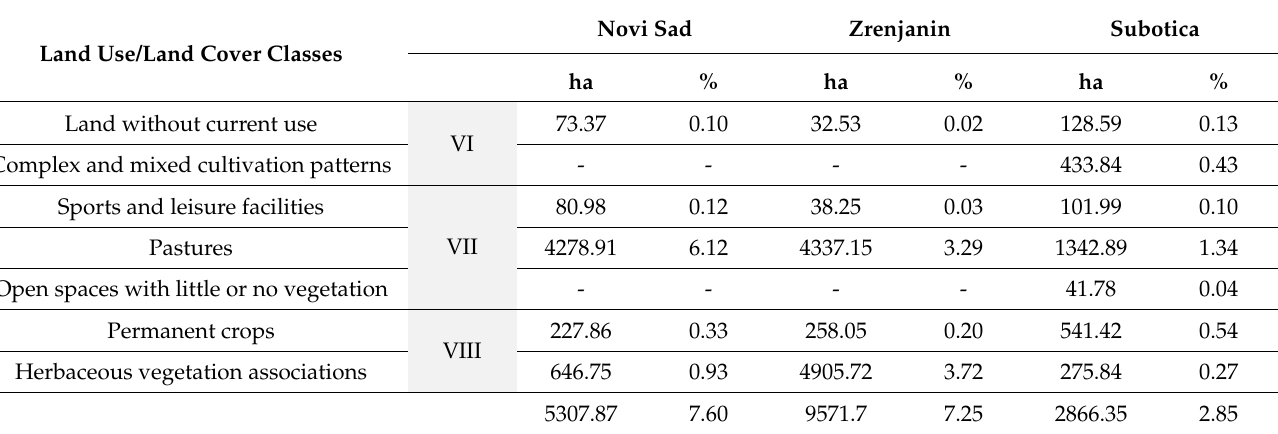
Table 5. Green infrastructure dots: potential land cover classes suitable for territorial cohesion